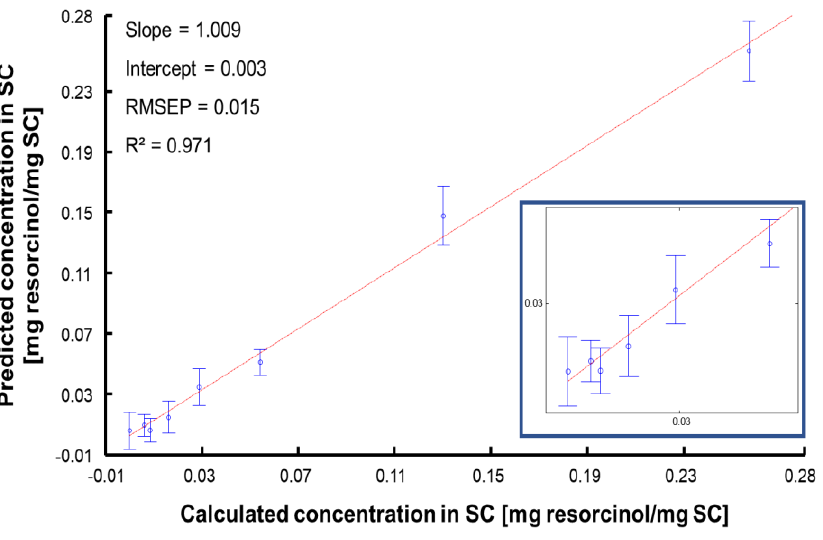
Figure 11. PLSR plot for the test set. Dots are mean predicted concentration and errors bars represent the standard deviation.